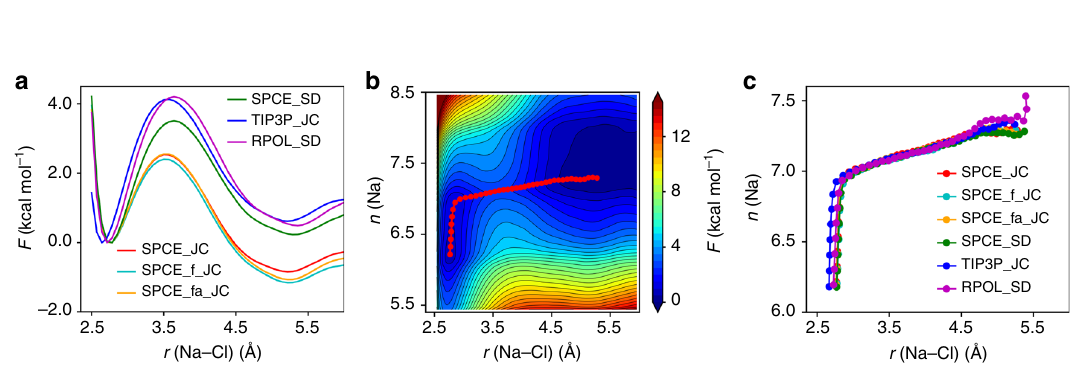
Fig. 3 Free energy surfaces (FESs) at high pressure and temperature. Results obtained with empirical potentials for 0.68 M solutions. Calculated 1D FESs ( a ), 2D FES ( b , obtained from SPCE_JC with minimum free energy path (MFEP) shown by the red dots), and MFEPs ( c ) obtained with different force fi elds.